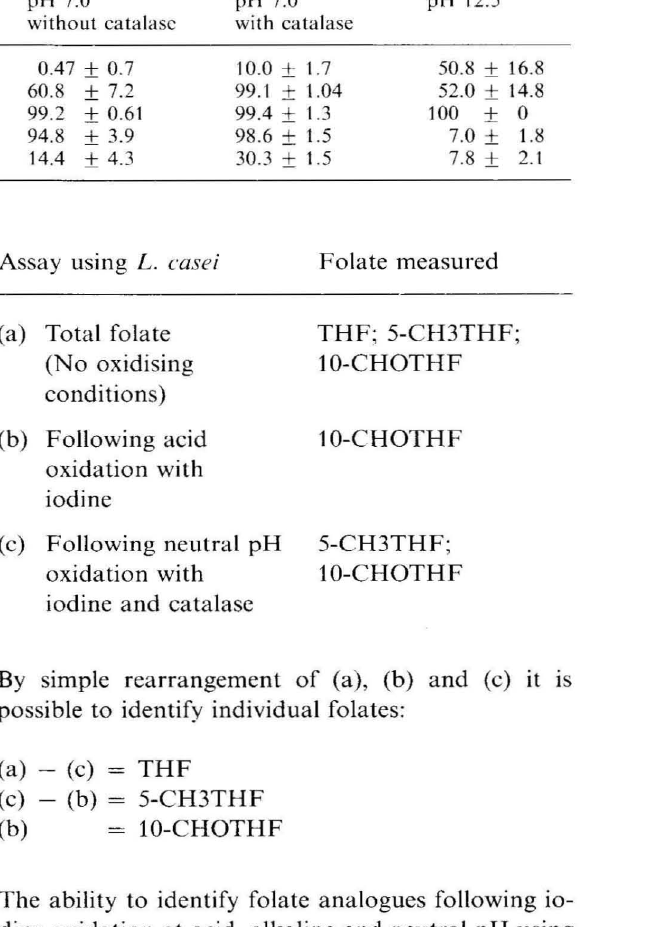
Table 1. Remaining L. cusei activity of folate expressed as a percentage and standard deviation after iodine oxidation at pH 1.5, pH 7.0 (before and after treatment with catalase) and pH 12.5 for 1 hour at 25 ' C in the dark. Folate